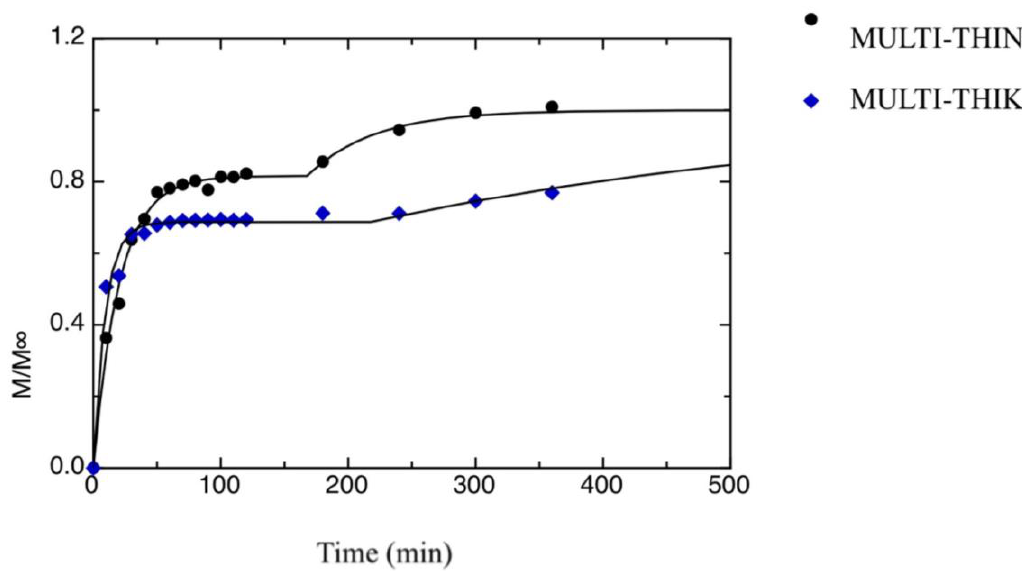
Figure 2. Release kinetics of SB in water from both MULT-THIN and MULT-THIK films, during the first stage of release. The curves in the figures represent the best fitting to the data.